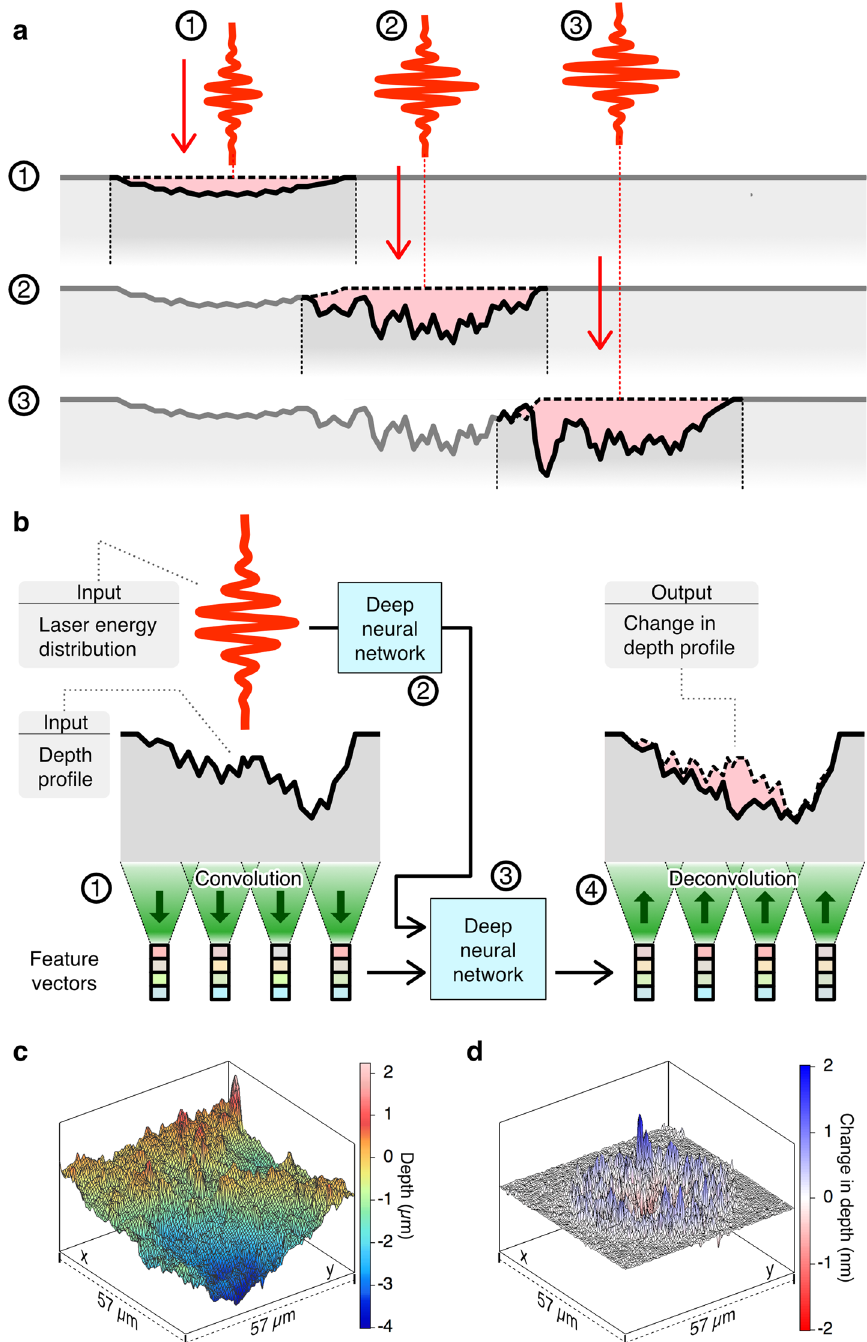
Figure 1. Schematic of laser ablation simulator using deep neural networks. ( a ) Simulation procedure. The simulator extracts a depth profile around an irradiation position as indicated by the vertical dotted lines and performs the calculation. The simulator calculates changes in the depth profiles caused by single-shot irradiation, represented by the pink shaded areas. The dashed lines and solid lines represent the depth profiles before and after irradiation, respectively. These calculations can be repeated at arbitrary irradiation positions using arbitrary pulse energies. ( b ) Configuration of the four deep neural networks. The first neural network performs a convolution to extract the feature vectors from the input depth profile. The second neural network calculates the responses to the incident laser pulse at each point. The third neural network combines the outputs from these two neural networks and calculates the nonlocal nonlinear interactions. The final neural network then performs a deconvolution to produce the output. ( c , d ) Three-dimensional representation of a typical training dataset. ( c ) Depth profile (96 × 96 pixels). ( d ) Changes in the depth profile (96 × 96